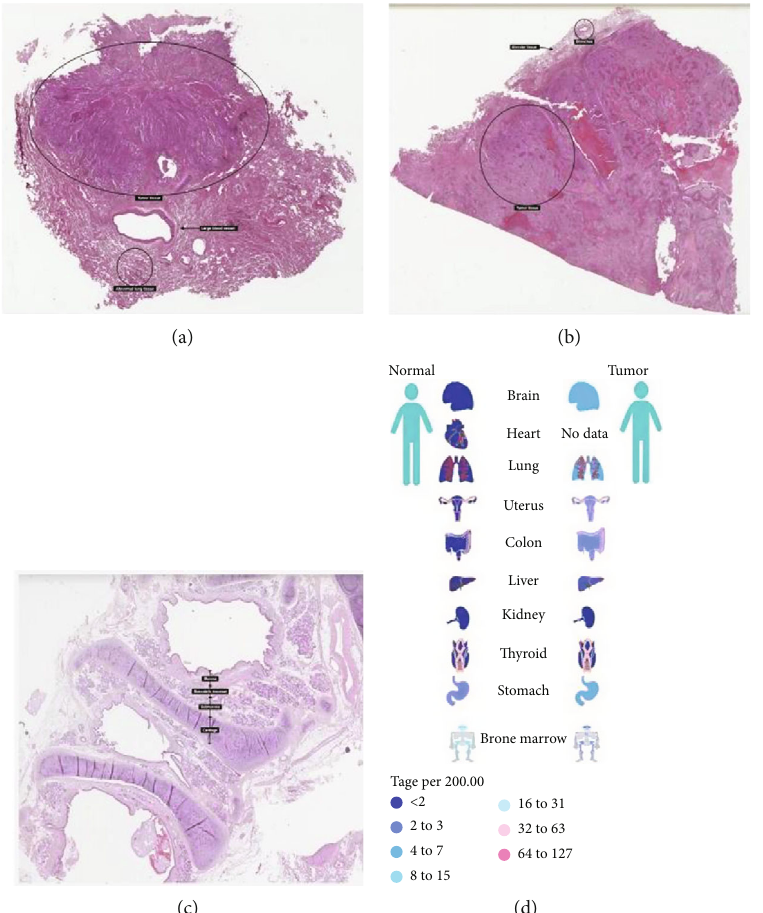
Figure 7: Use Protein Atlas network database (https://www.proteinatlas.org/) to analyze: (a) is the HE staining result of NUF2 in lung adenocarcinoma, and (b) is the HE staining result of NUF2 in lung squamous cell carcinoma. (c) is the HE staining result of NUF2 in normal bronchus. (d) is the use of SAGE to analyze NUF2 in human